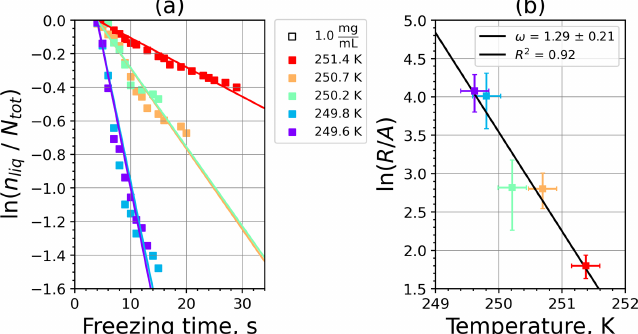
Figure A3. (a) The decrease in fraction of droplets which remained liquid with time at different temperatures in the isothermal experiments of microcrystalline cellulose (MCC) at the M-WT. The colors correspond to different temperatures (particle concentrations of 1gL − 1 ). Typical error bars are depicted in Fig. 6. (b) Freezing rate of MCC normalized to surface area as a function of temperature.